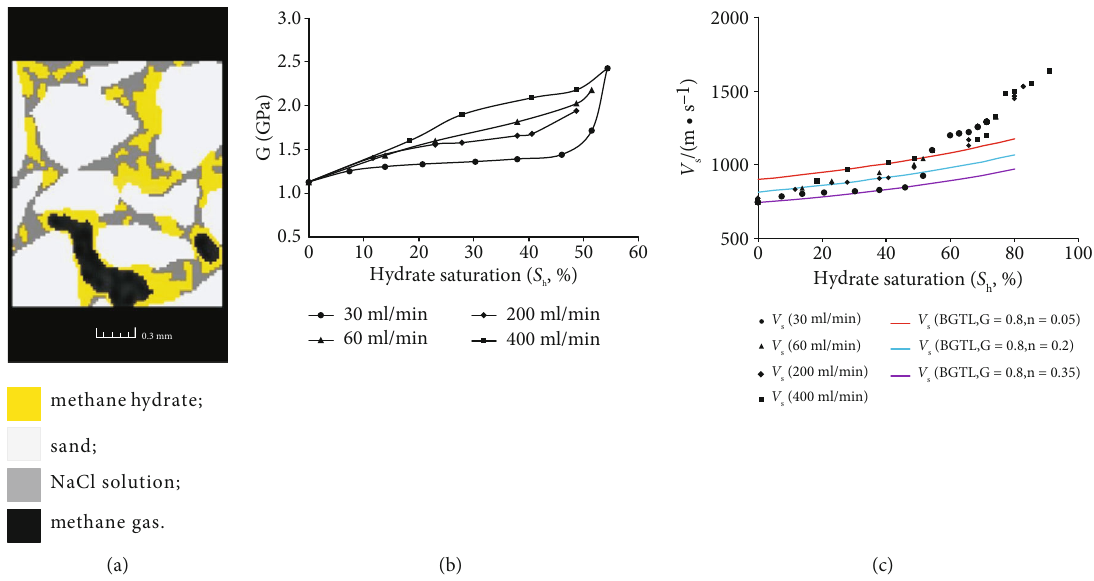
Figure 11: Hydrate distribution with changes in shear modulus and shear wave velocity. (a) Pore scale distribution of gas hydrates in sediments by X-CT (modi fi ed from [19]), (b) Variation in shear modulus with hydrate saturation in di ff erent methane fl ux, (c) Variation in S- wave velocities with hydrate saturation and analysis of the value of BGTL theory (Data for Figure 11 are in Table S10 in the Supplementary